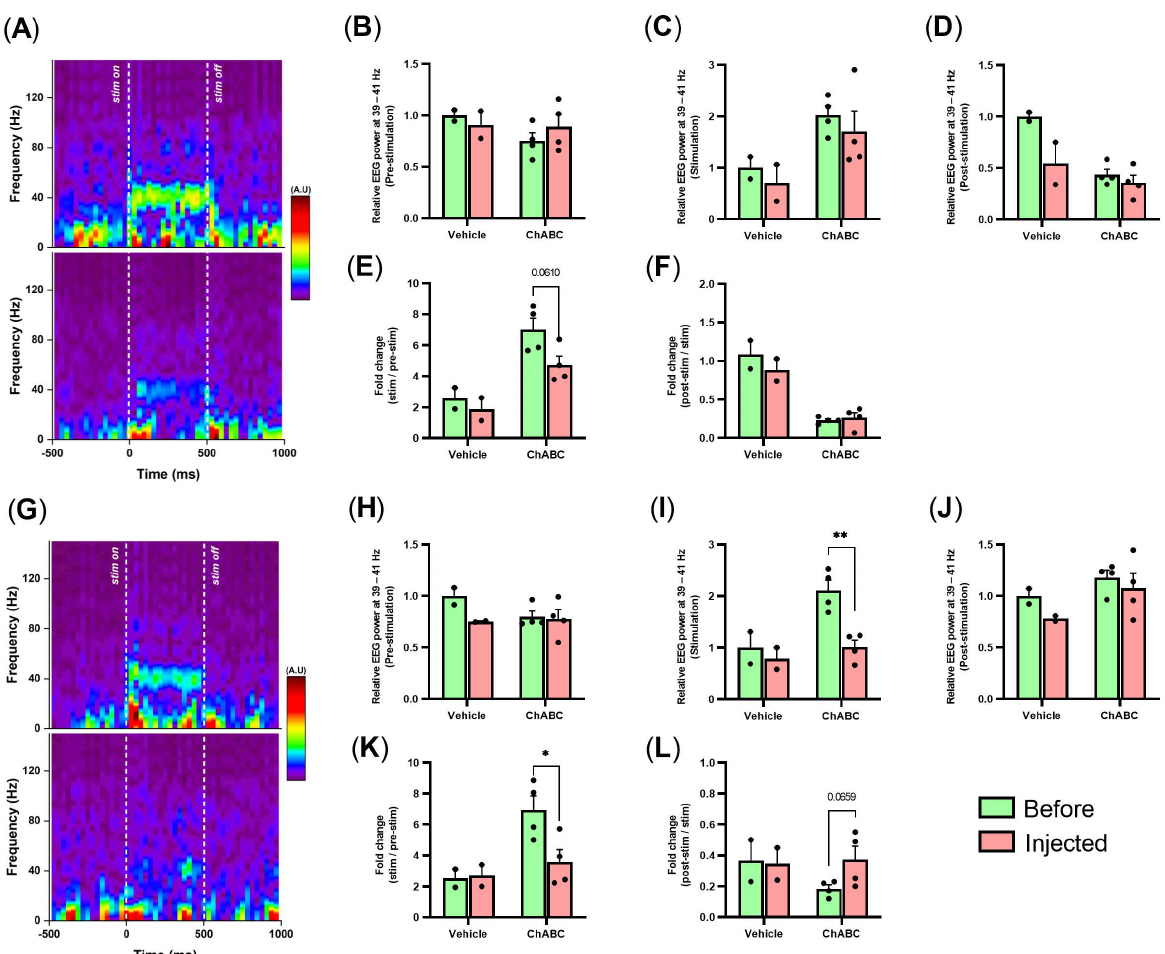
Figure 6. Optogenetically- and auditory-evoked GBO reduced by ChABC injection. ( A ) Represen- tative optogenetically-evoked time-frequency spectrogram of frontal EEG from before and after ChABC injection (before, top; after, bottom). ( B – D ) Relative EEG power at 40 ± 1 Hz during the pre-stimulation, stimulation, and post-stimulation periods by optogenetic stimulation. ( E ) Fold change during the stimulation period in comparison with the pre-stimulation period by optogenetic stimulation. ( F ) Fold change during the post-stimulation period in comparison with the